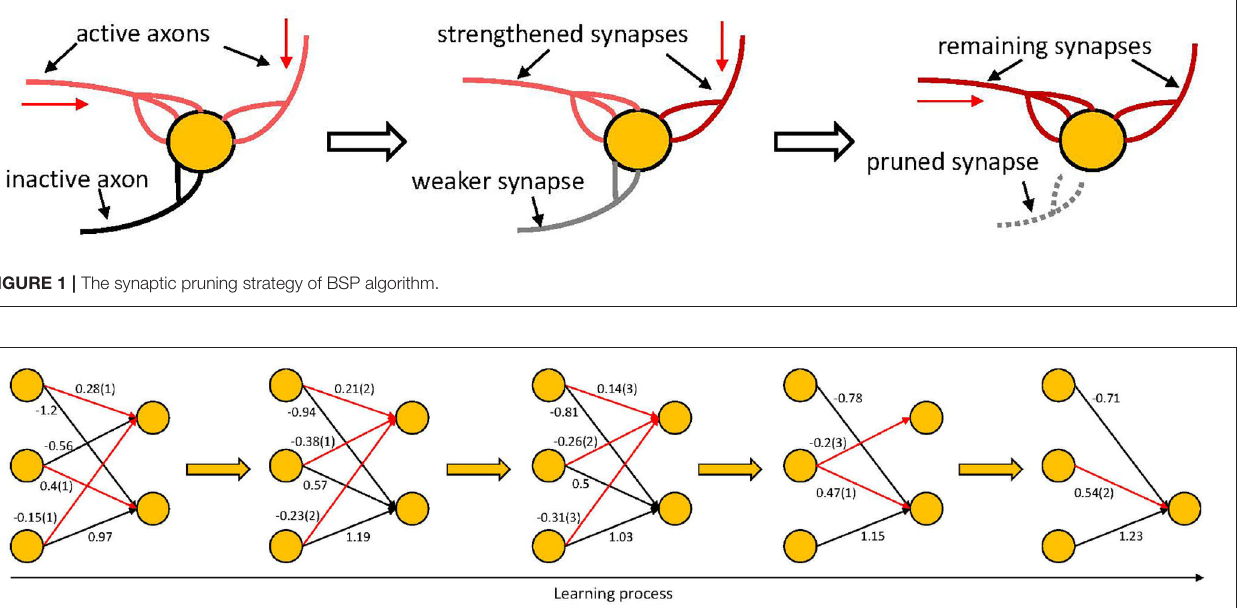
FIGURE 2 | The detailed pruning process of BSP algorithm. The red connections represent the candidate pruned